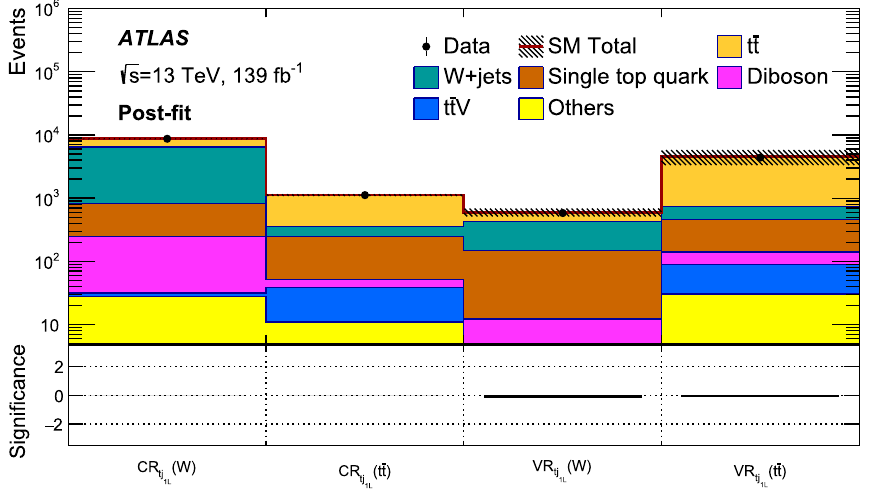
Fig. 7 Comparison of the predicted backgrounds with the observed numbers of events in the CRs and VRs associated with the tj 1L channel. Thenormalisationofthebackgrounds isobtainedfromthebackground- onlyfittotheCRs.Theupperpanelshowstheobservednumberofevents andthepredictedbackgroundyield.The‘Others’categoryincludescon-